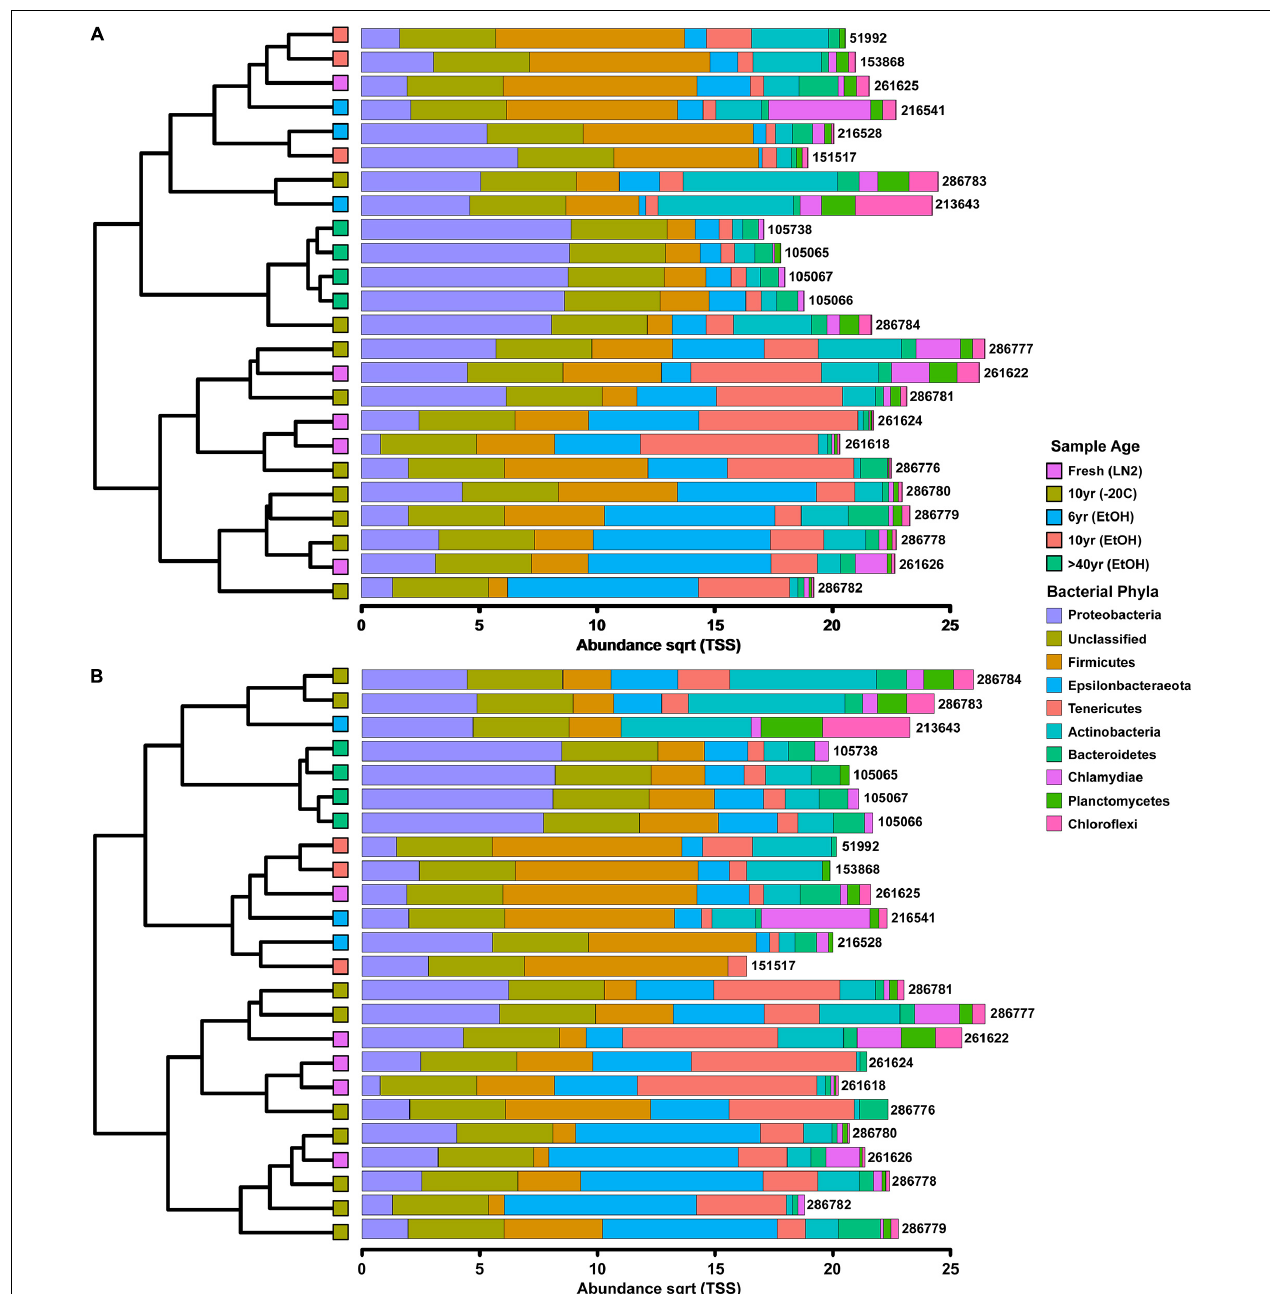
FIGURE 1 | Clustered-bar charts (A) depicting phyla level (top 10) variation in gut microbiota composition across sample age based on OTUs and (B) depicting phyla level (top 10) variation in gut microbiota composition across sample age based on ASVs.